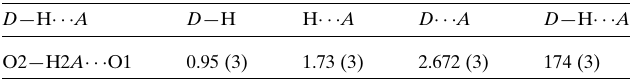
Table 1 Hydrogen-bond geometry (A˚ , (cid:3) ).